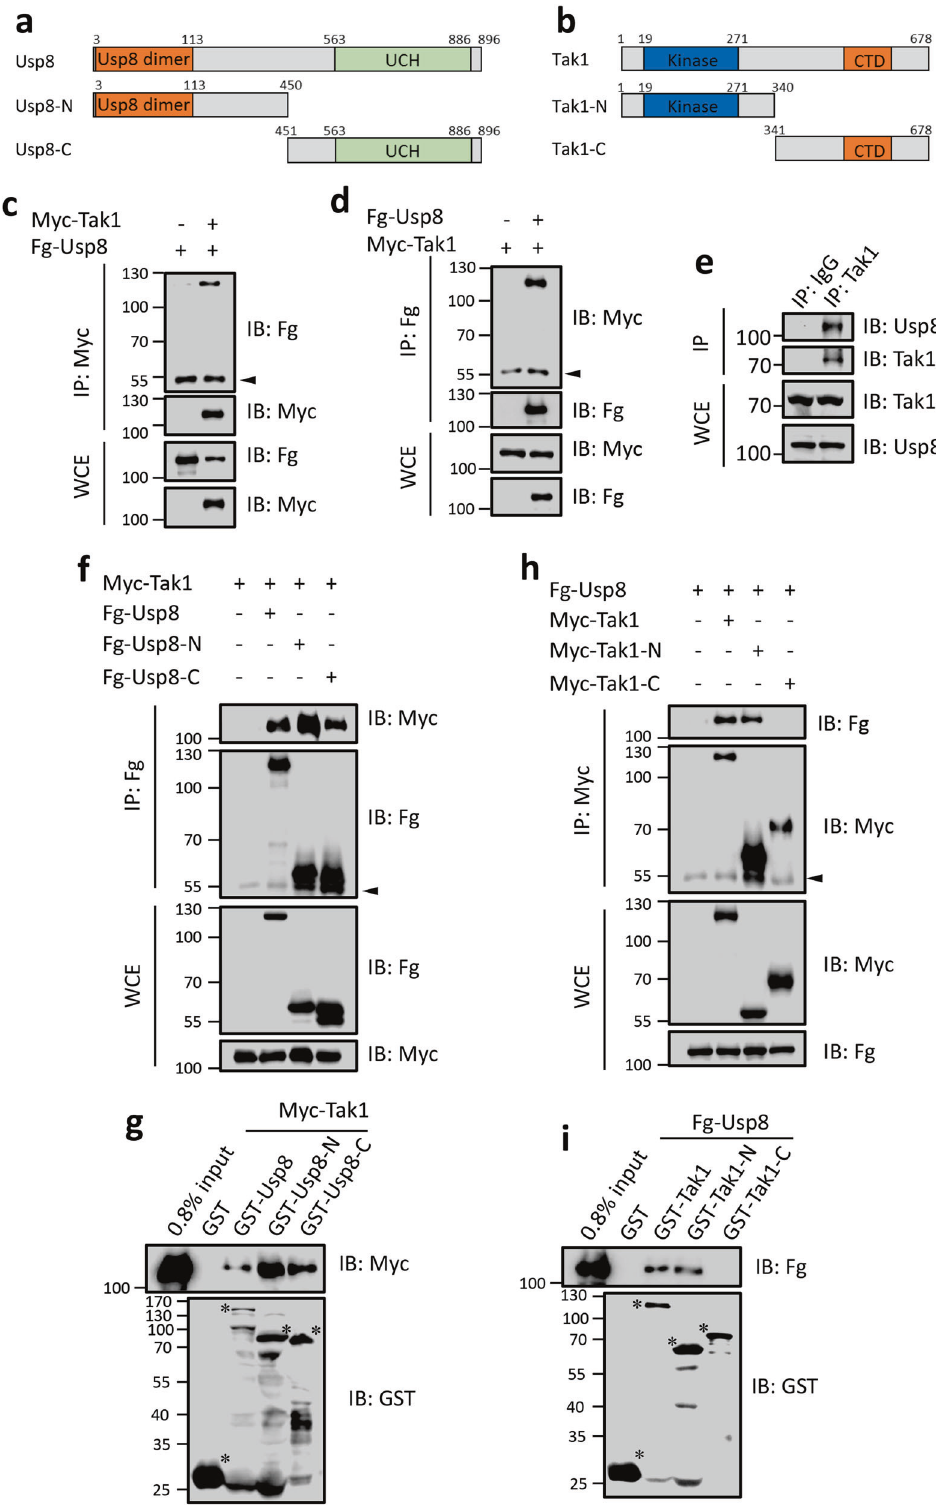
Fig. 4 Usp8 interacts with Tak1. a , b The schematic diagrams show the domains in Usp8 and Tak1, and their truncated constructs used in the following co-IP and GST pull-down assays. Orange and green bars represent the Usp8 dimerization domain (Usp8 dimer) and ubiquitin carboxyl-terminal hydrolase domain (UCH) of Usp8, respectively. Blue and orange bars indicate the kinase domains and C-terminal domain (CTD) of Tak1, respectively. c Myc-Tak1 could pull down Fg-Usp8 in 293 T cells. The arrowhead indicates the IgG. d Fg-Usp8 pulled down Myc- Tak1 in 293 T cells. e In the third instar larval stage, endogenous Tak1 interacted with endogenous Usp8. f Myc-Tak1 interacted with Fg-tagged N- and C-fragments of Usp8. g GST pull-down between Myc-Tak1 and GST or GST-tagged Usp8 truncated constructs. Asterisks mark expressed GST fusion proteins. h Tak1 interacted with Usp8 through its N-terminal region in 293 T cells. i GST pull-down between Fg-Usp8 and GST or GST-tagged Tak1 truncated constructs. Cell Death and Disease (2022)